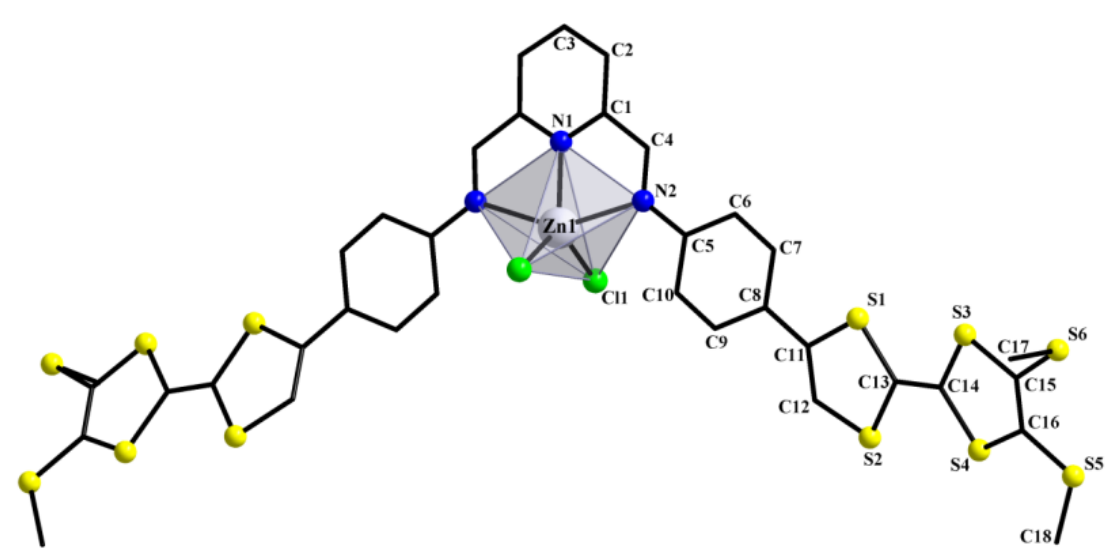
Figure 3. The crystal structure of complex 4 with the labeling scheme of the atoms. Hydrogen atoms have been omitted for